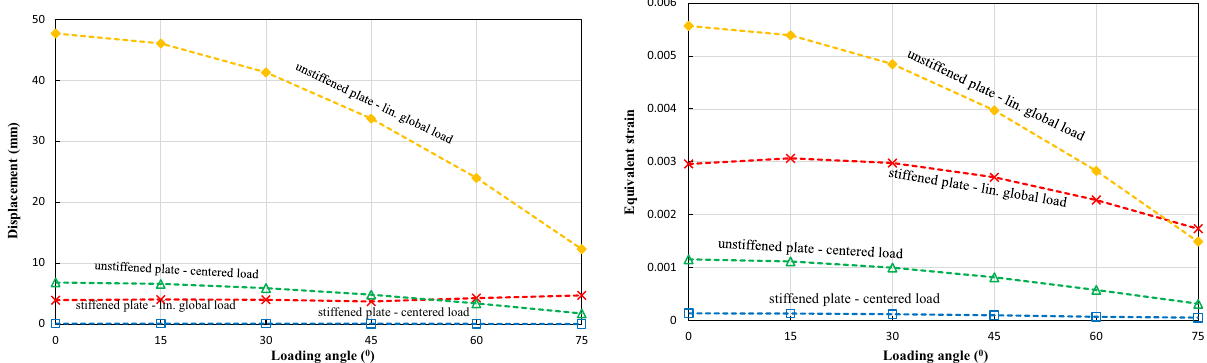
Figure 9: Maximum displacement value of sti ff ened and unsti ff ened medium - carbon steel materials.